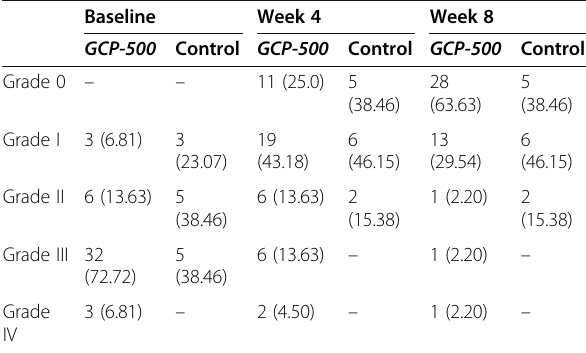
Table 2 Summary of the Overall Effect of the Treatments using the 5-point Grading System (Primary